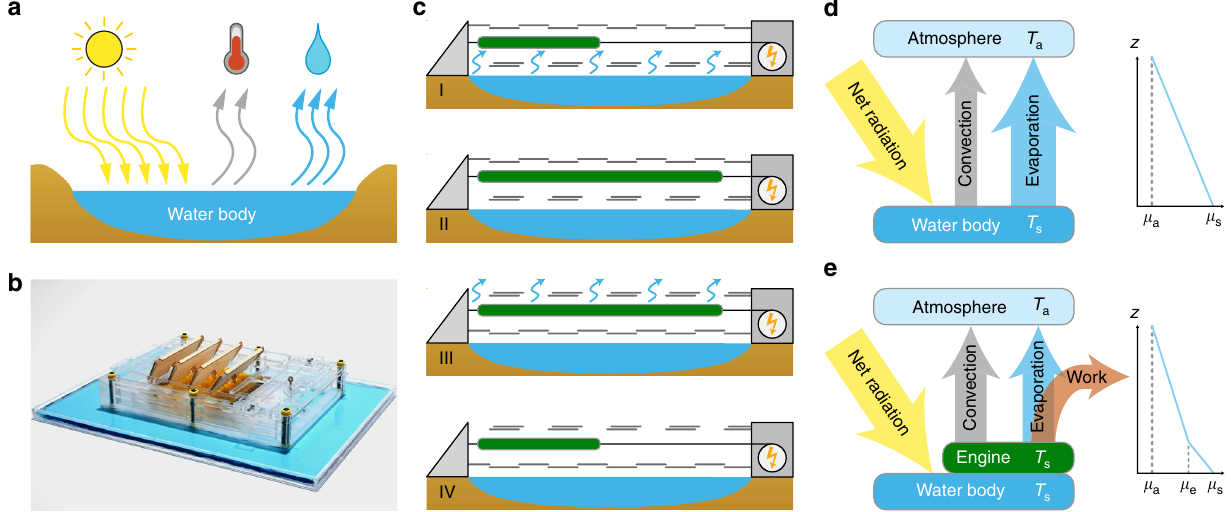
Fig. 1 The surface energy balance in the absence and presence of an evaporation-driven engine. a The net radiative energy into a water body is balanced by convection and evaporation. b An example of an evaporation-driven engine, incorporating water-responsive materials, placed at the water surface can harness energy from evaporation 12 . c Such an engine harnesses energy from evaporation through a 4 stage cycle: (I) With the upper shutters ( gray jagged line ) closed, the water-responsive material ( green block ) swells, absorbing water vapor at the high chemical potential μ s . (II) At maximum absorption, the upper shutters open as the bottom shutters close. (III) With the upper shutter open, the water-responsive material shrinks, releasing water that evaporates away into the atmosphere at a lower chemical potential μ e . (IV) At maximum desorption, the upper shutters close as the bottom shutters open, restarting the engine cycle. d The fl ows between the water body and the atmosphere occur along a thermal gradient between T s and T a for convection and along a chemical gradient between μ s to μ a for evaporation. e The new energy balance can be illustrated between net incoming radiation, convection, evaporation, and work extracted between μ s and μ